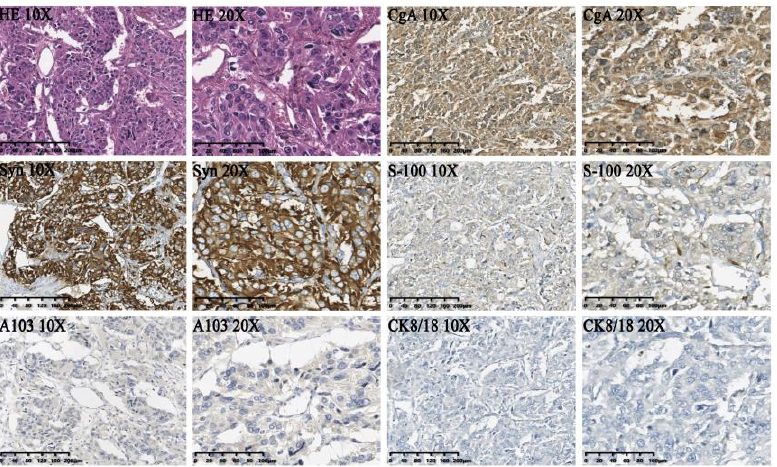
Figure 3. Histopathological features and immunohistochemical profiles of the paraganglioma: CgA (+), Syn (+), S-100 supporting cells (+), A103 ( − ), CK8/18 ( − ).